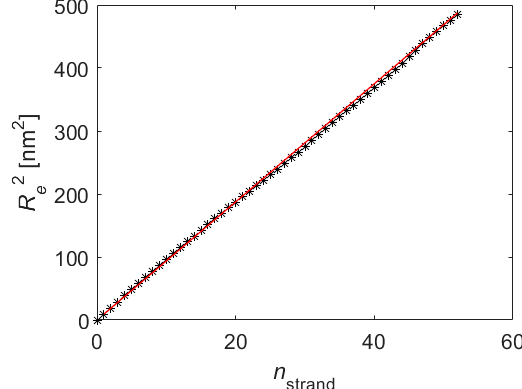
Figure 5. Slip spring length distribution of a crosslinked polymer network created by random crosslinking. Polymers 2018 , 10 , x FOR PEER REVIEW 17 of 26